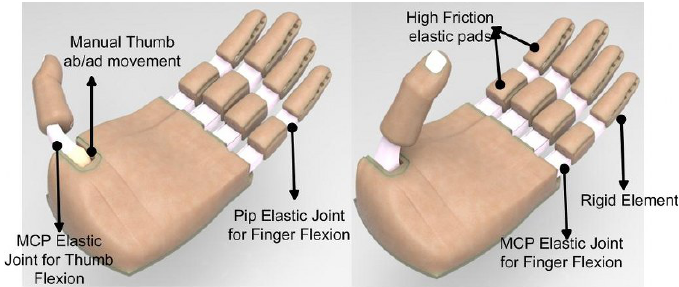
Figure 2. Conceptual design of the Softhand: Each finger is composed of MCP and PIP joints and does not include the DIP joint. The thumb is composed of CMC and MCP joints. Except the non/actuated thumb abduction/adduction joint, all other joints are fabricated with elastic